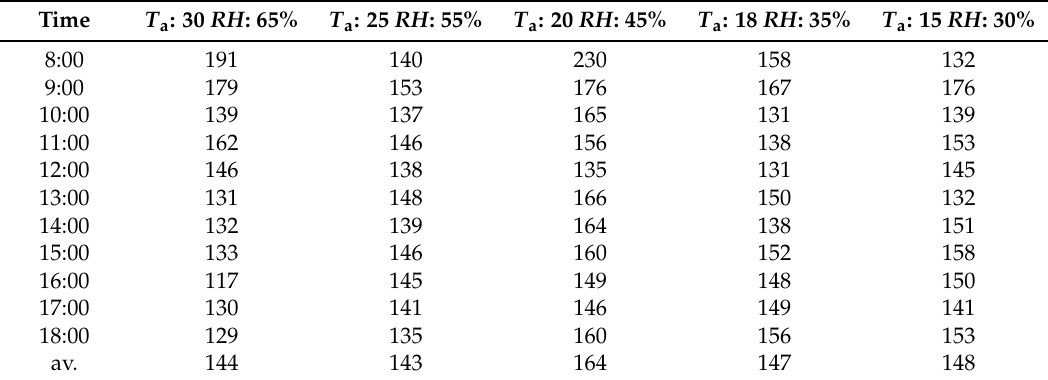
Table 1. r a – loc (s/m) measured at a height of 0.5 m.